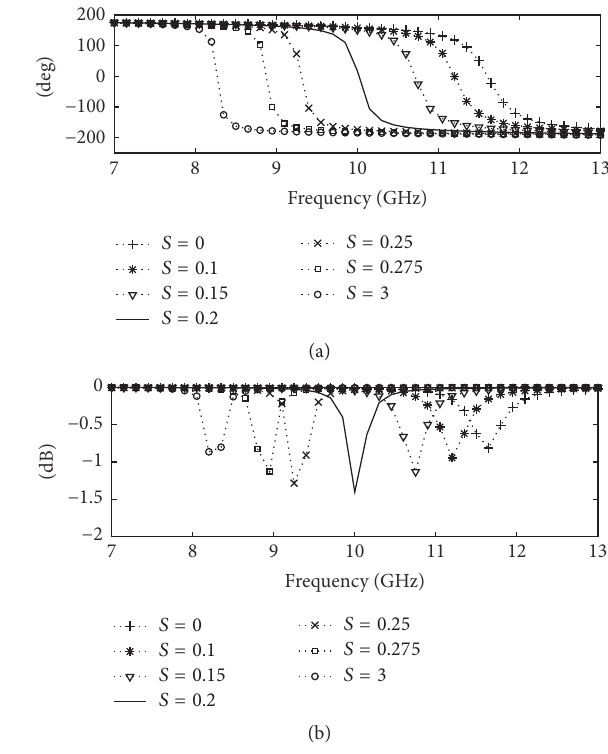
Figure 8: (a) Phase and (b) amplitude of the simulated reflection coefficient versus frequency for different value of the scaling factor 𝑆 (1st iteration fractal unit cell with 𝐿 = 7.86 mm and Δ𝑥 × Δ𝑦 = × 0.6𝜆 0.6𝜆 0 0